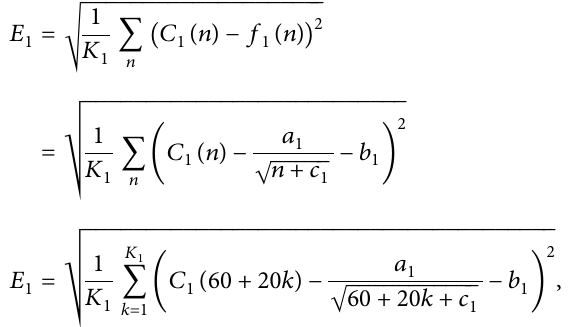
Table 5: The relative error of I